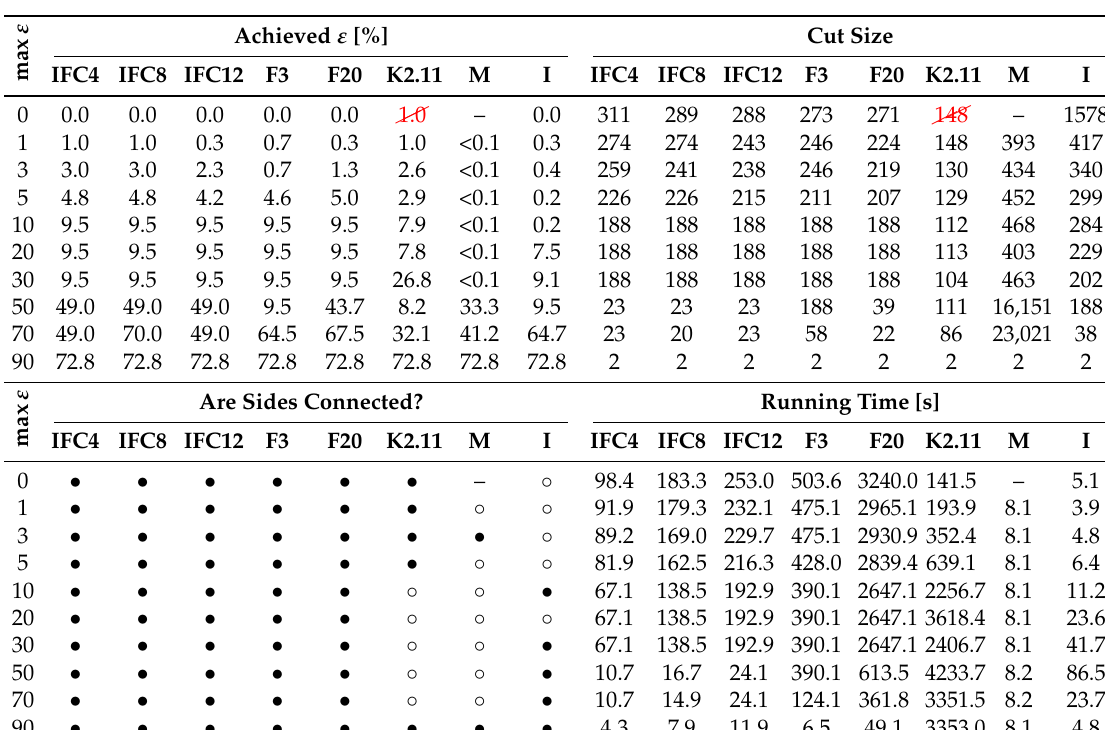
Table 6. Pareto cuts of